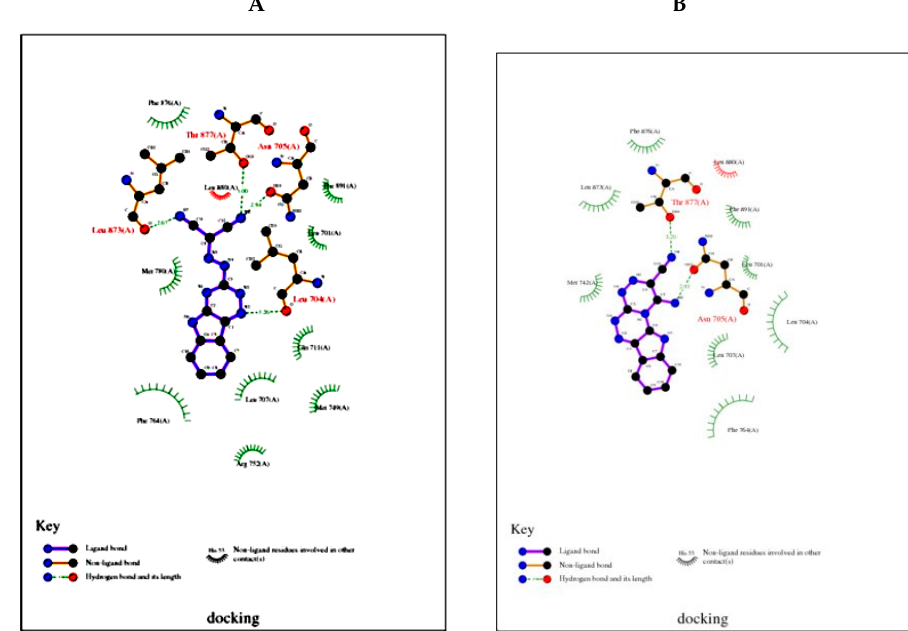
Figure 5. ( A ). 2D plot of interaction between the compound 3 receptor prostate cancer (2q7k); ( B ). 2D plot of interaction between the compound 4 and receptor prostate cancer (2q7k).